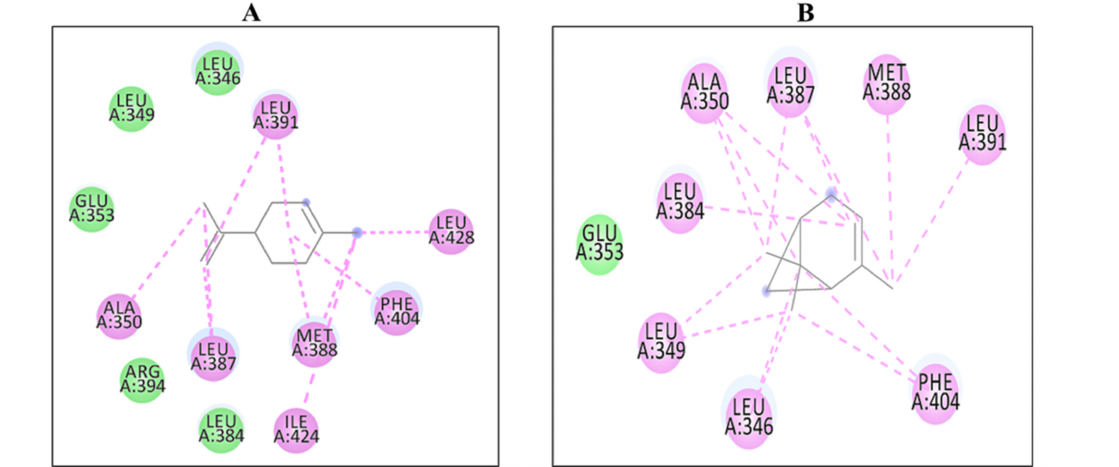
Figure 1. 2D Interaction complexes of ( A ) D-limonene and ( B ) α -pinene with 6CHZ